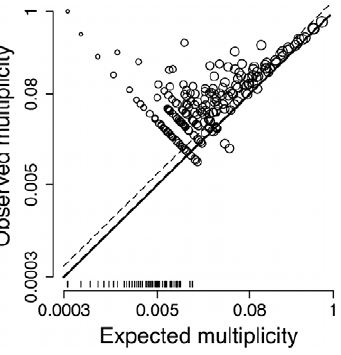
site distribution corresponding to each PWM against the multiplicity expected under a Poisson distribution ( M Exp ) (data in Table S3). Axes are log-transformed. Values of M vary between 0 (all binding sites found in single copies in different intergenic regions) and 1 (all binding sites found in multiple copies). The area of the circles is proportional to the log of the total binding site count for the PWM. The bold line shows the expectation M Obs ~ M Exp ; the dashed line shows the median excess multiplicity ( M Obs = M Exp ~ 1 : 4 ). Vertical lines denote cases where M Obs ~ 0 .